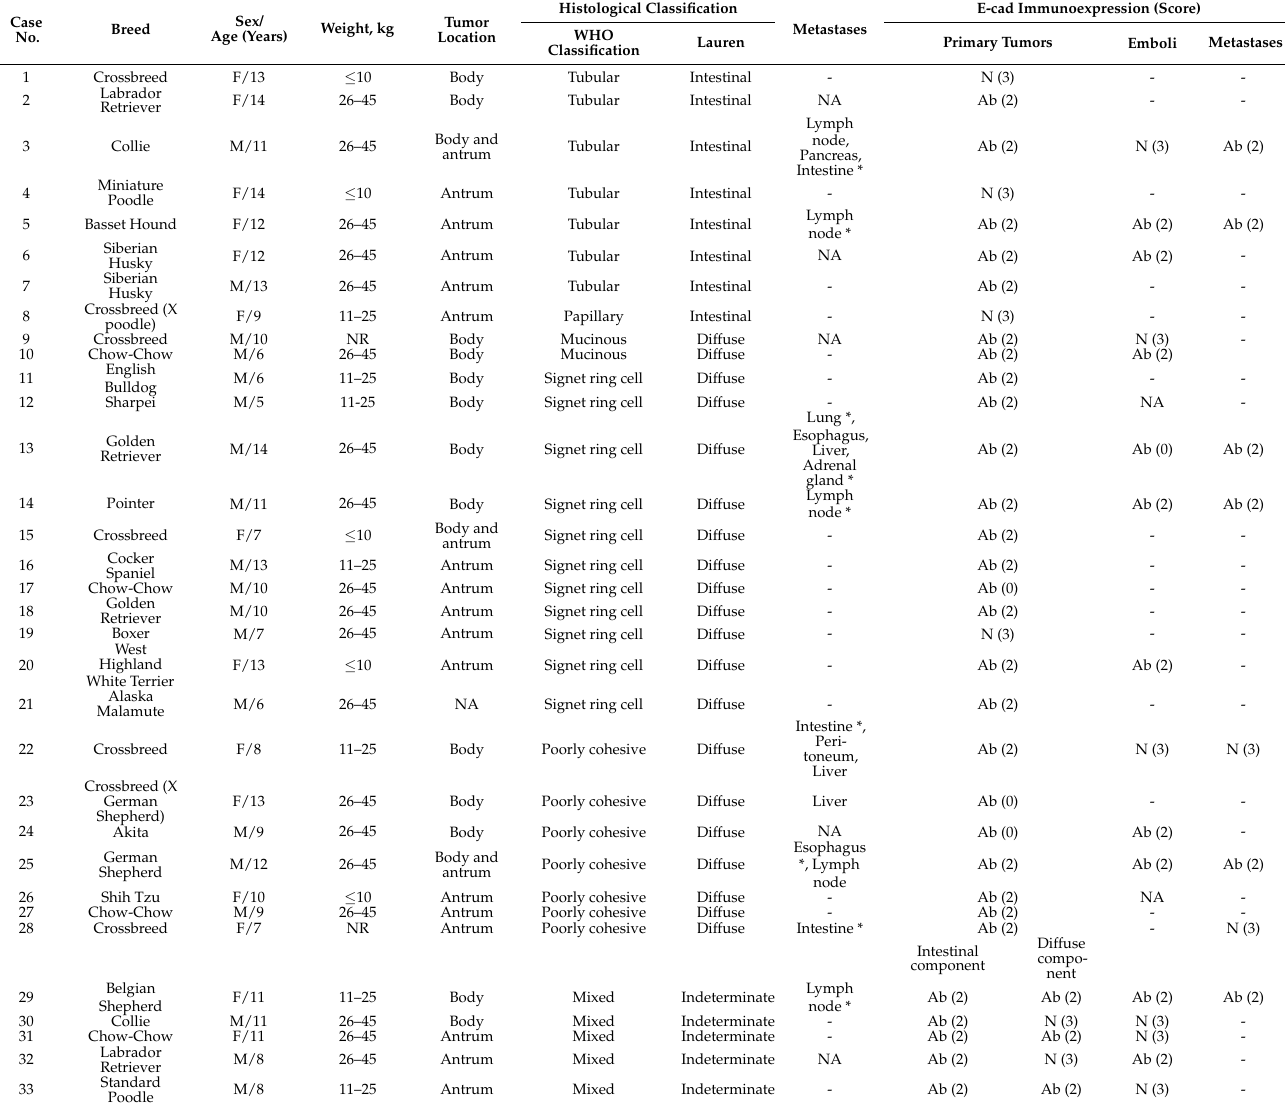
Table 1. Epidemiological data of the animals, characteristics of the tumors and main immunohisto- chemical